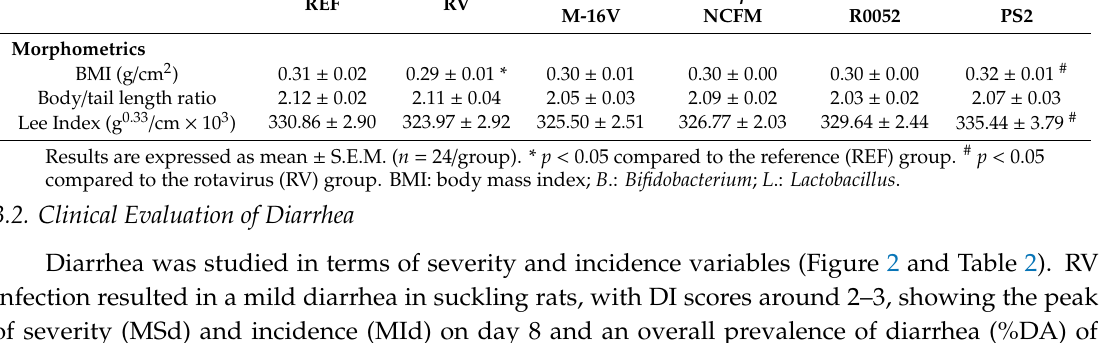
Table 1. Growth-associated measurements at the end of the study (day 14).